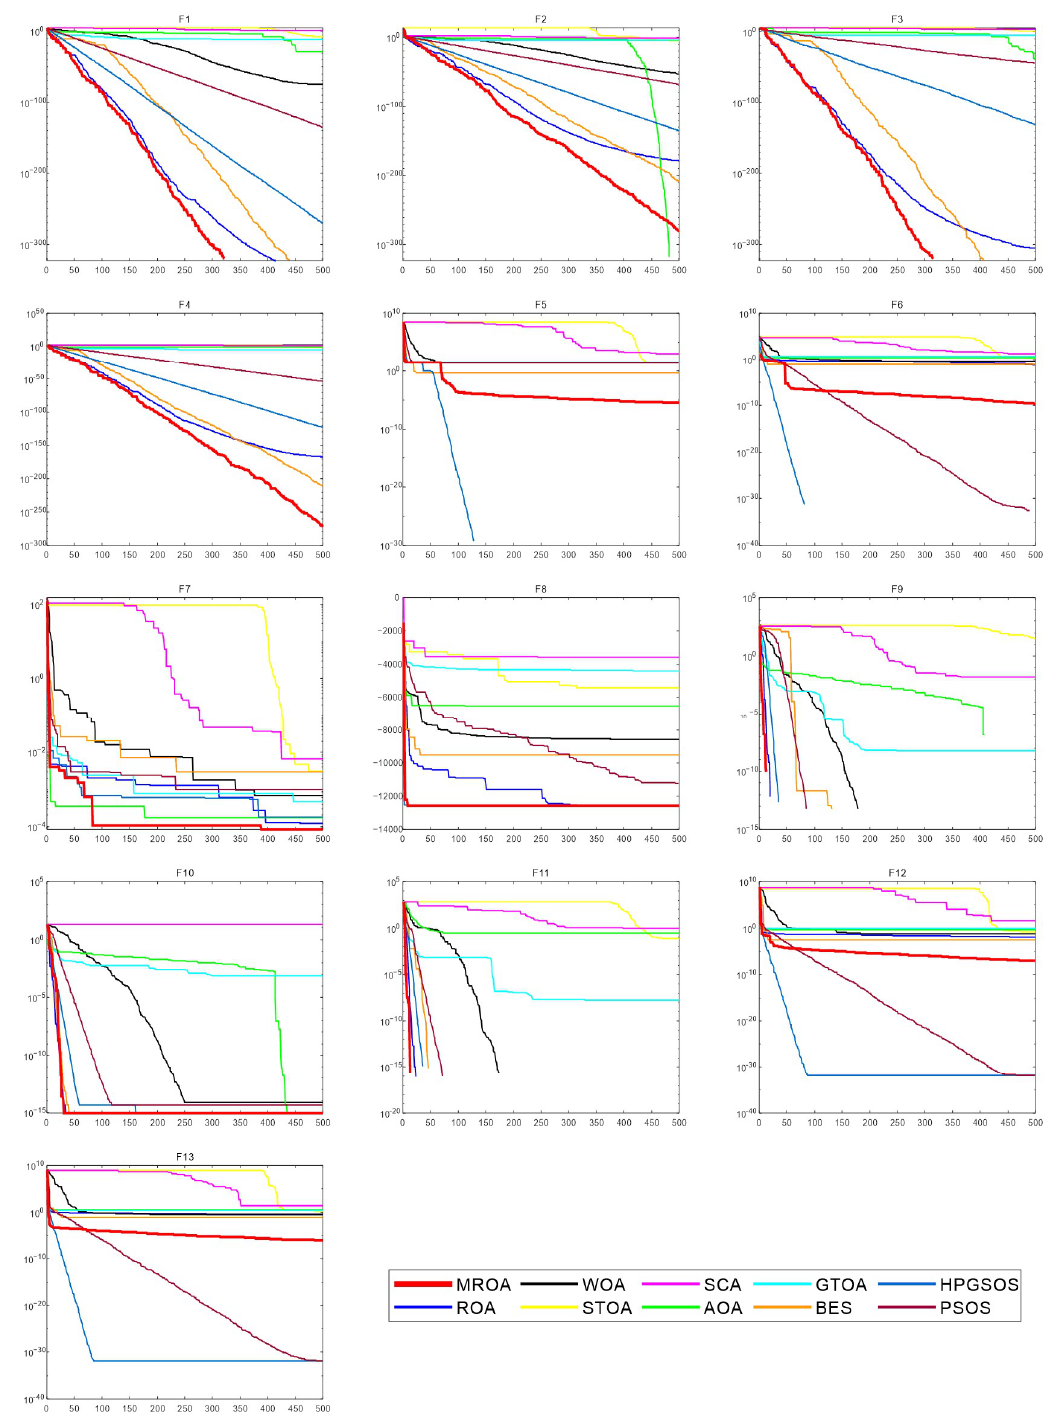
Figure 5. The convergence curves for the optimization algorithms on test functions (F1–F13) with dim = 30.